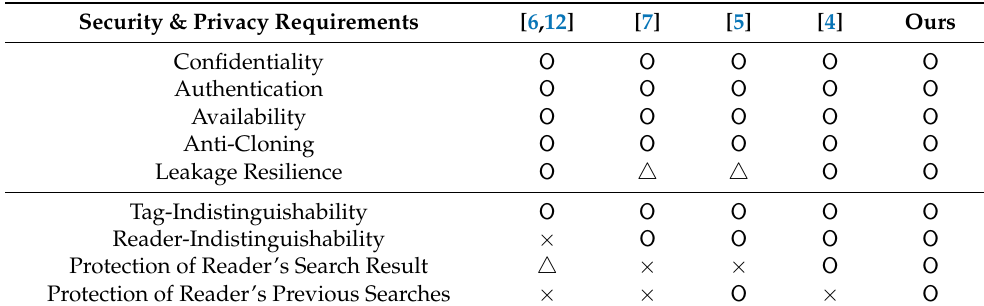
Table 4. Security & Privacy Comparisons. O MEANS “S ATISFY ”, × MEANS “N OT S ATISFY ”, AND (cid:52) MEANS “P ARTIALLY S ATISFY